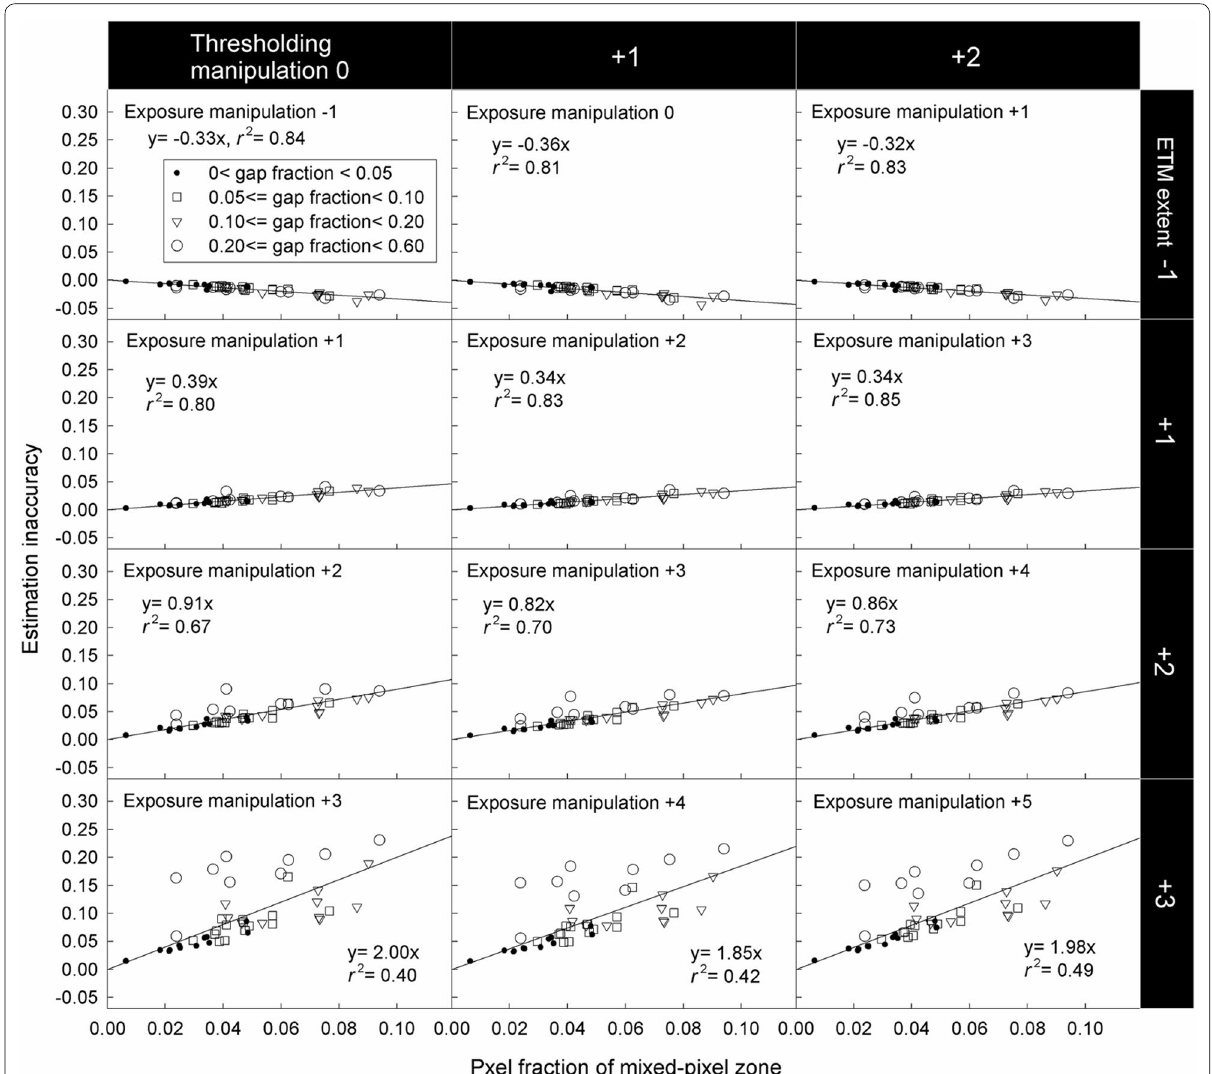
Fig. 10 Effects of the mixed‑pixel zone length (i.e. pixel fraction of mixed‑pixel zone), canopy gap fraction and the ETM extent on the HP estimation derived from real CHPs taken in 46 locations. The unit of the exposure manipulation, thresholding manipulation and ETM extent is